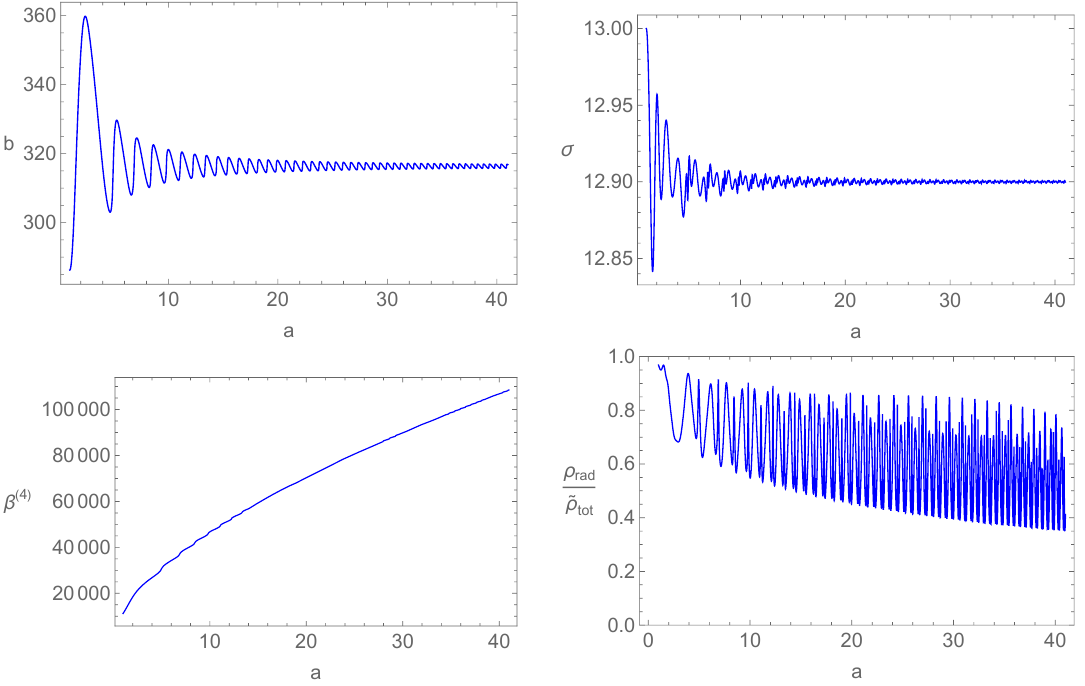
Figure 14. The 3D scale factor a as a function of t , and the 2D scale factor b , the inverse temperature measured by M , i.e., β (4) and the ratio ρ ˜ ρ as functions of the 3D scale factor a . 4 rad / tot The parameters are chosen as (4.17) and (4.18). Note that a = 41 corresponds to t = 10 5